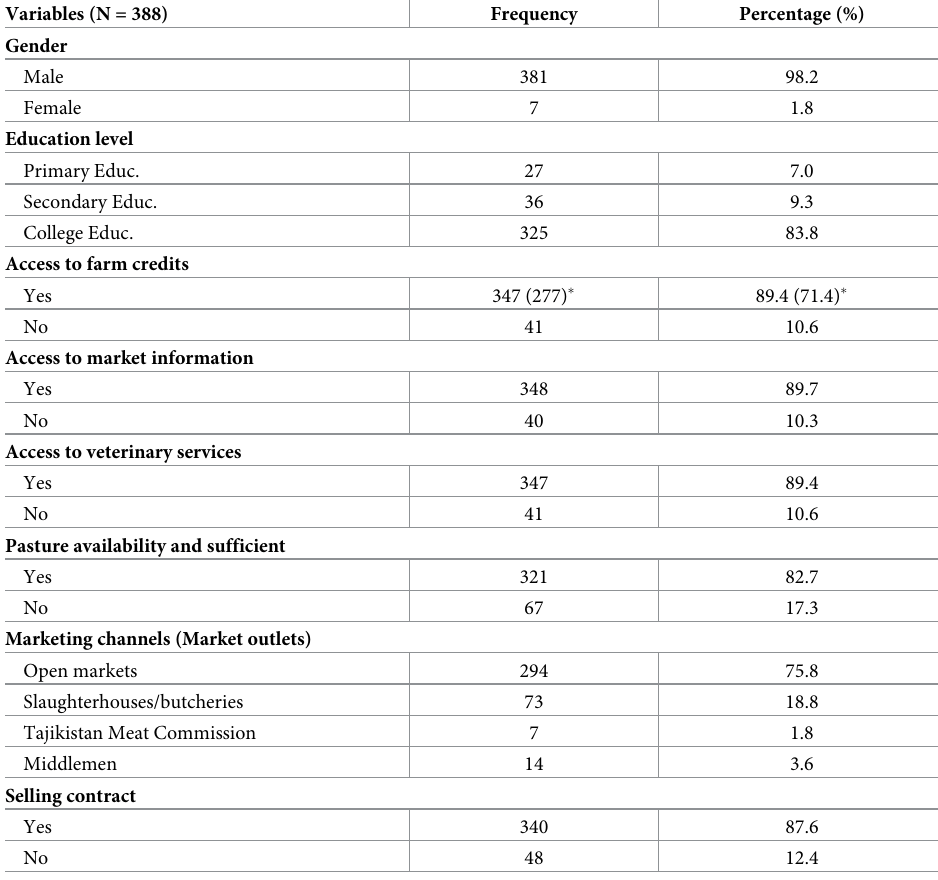
Table 4. Socioeconomic characteristics of smallholder beef cattle farmers based on frequency and percentage scores of categorical variables.